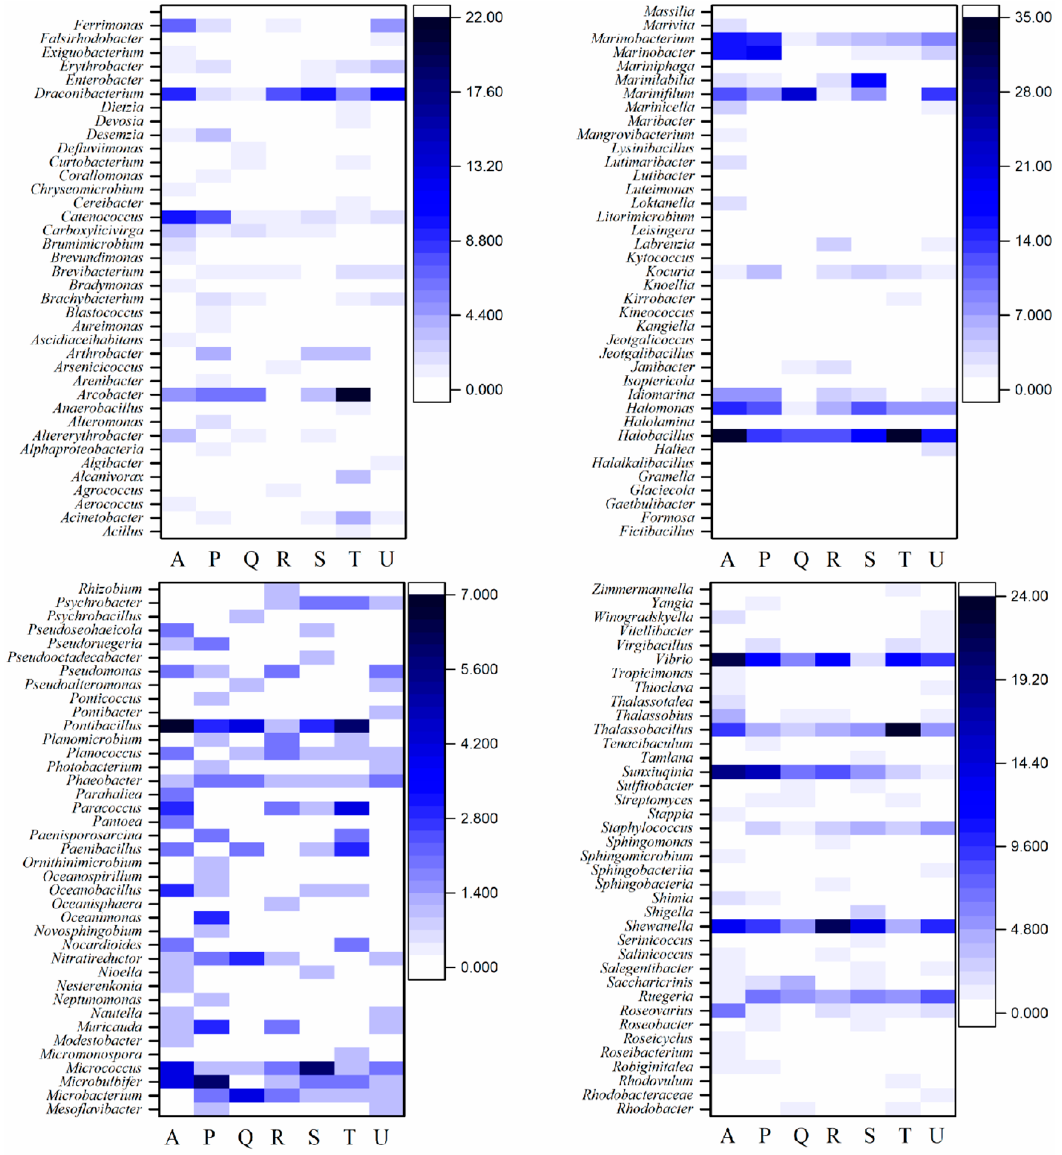
Figure 4. Culturable bacterial community compositions of di ff erent groups at genus